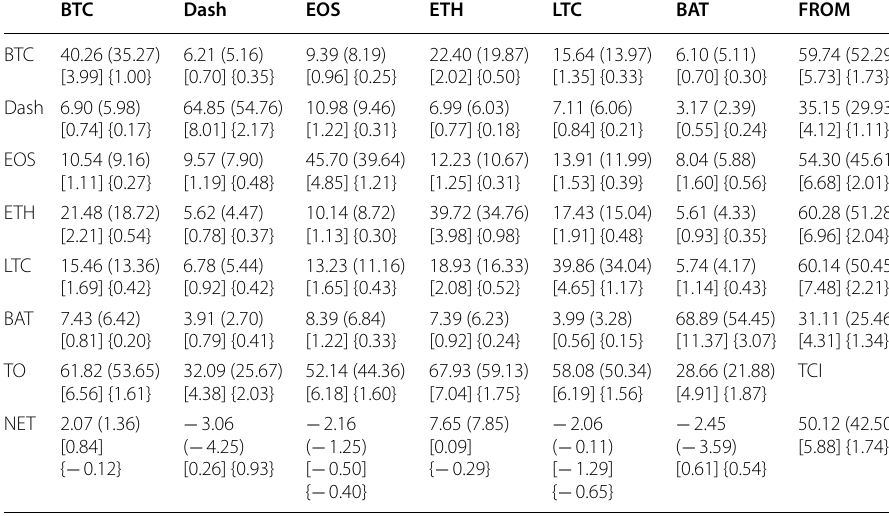
Table 6 Averaged connectedness